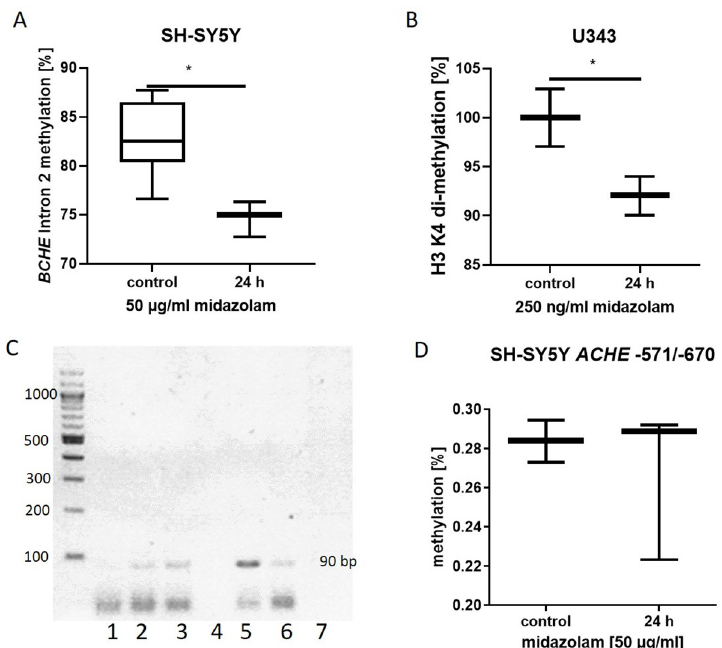
Fig 3. Methylation of BCHE in neuronal SH-SY5Y and U343 cells after midazolam incubation A) BCHE intron 2 methylation reduced after midazolam (50 μ g/ml) exposure of SH-SY5Y cells (n = 3; p = 0.01) analyzed by methylation specific PCR. B) ELISA showed that histone H3 lysine 4 di-methylation (H3K4me2) decreased in U343 cells after incubation with 250 ng/ml midazolam (n = 3; p = 0.02) C) Chip-Assay confirmed binding of BCHE promoter region (90 bp) to H3K4me2; a 100 bp DNA Ladder was utilized; lanes 1, 7 show incubation with H3K27 antibody; lanes 2 and 6 show incubation with H3K4 antibody; lane 4 shows negative control without antibody and lane 5 shows positive control with RNA-polymerase II antibody (two experiments out of three are shown; n = 3). D) ACHE -571-/-670 promoter methylation was not affected by midazolam (50 μ g/ml) exposure of SH-SY5Y cells (n = 3; p = n.s.) analyzed by methylation specific PCR. Data are presented as mean ± standard deviation.